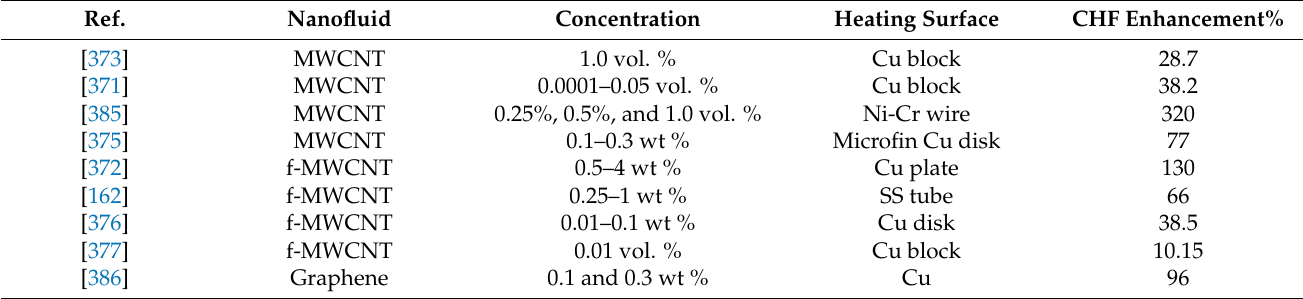
Table 8. Summary of selected HTC enhancement for various pool boiling studies in water base.